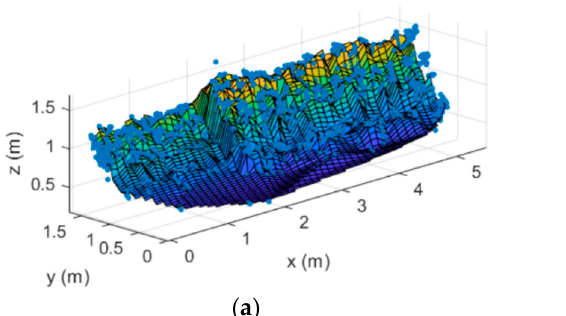
Figure 6. Surface reconstruction of the stockpile-alike model following ( a ) proc1 and ( b ) proc2 procedures. Table 1. Real and reconstructed dimensions of the stockpile. Figure 5. ( a ) Scanning area; ( b ) rover modules positions and ( c ) point cloud retrieved from a round trip scanning path.